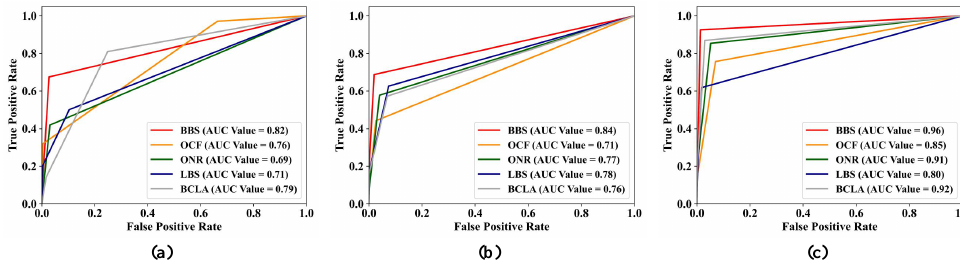
Figure 15. The ROC of ( P D , P F ) for the UTD results on the Nano-Hyper data set with different band selection methods. The number of selected bands is ( a ) 22, ( b ) 34, ( c )